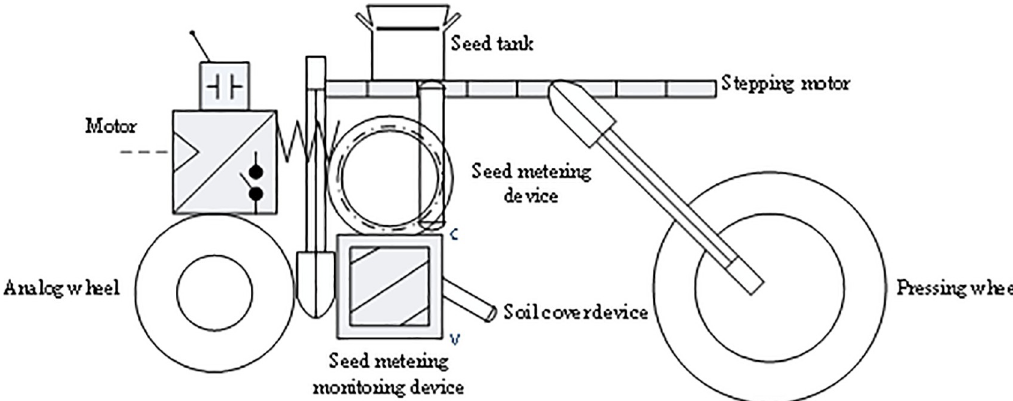
Fig 1. General structure of a corn precision